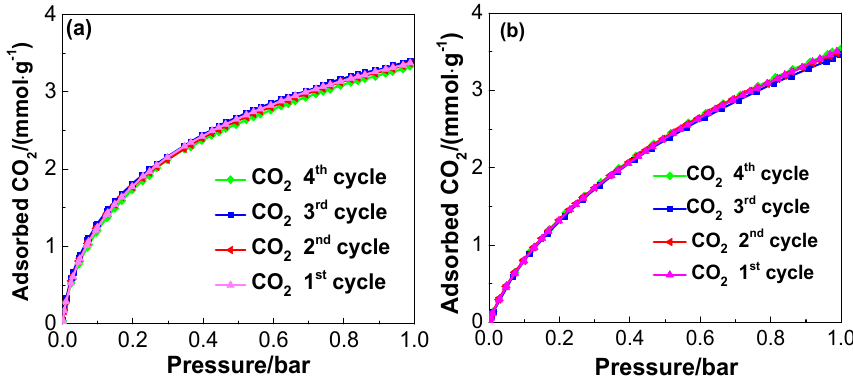
Figure 12. CO 2 adsorption performances on the PUF/C-CO 2 -1173 at 273 K ( a ) and PUF/C-KOH-973 at 298 K ( b ) within four repeated cycles with regeneration .